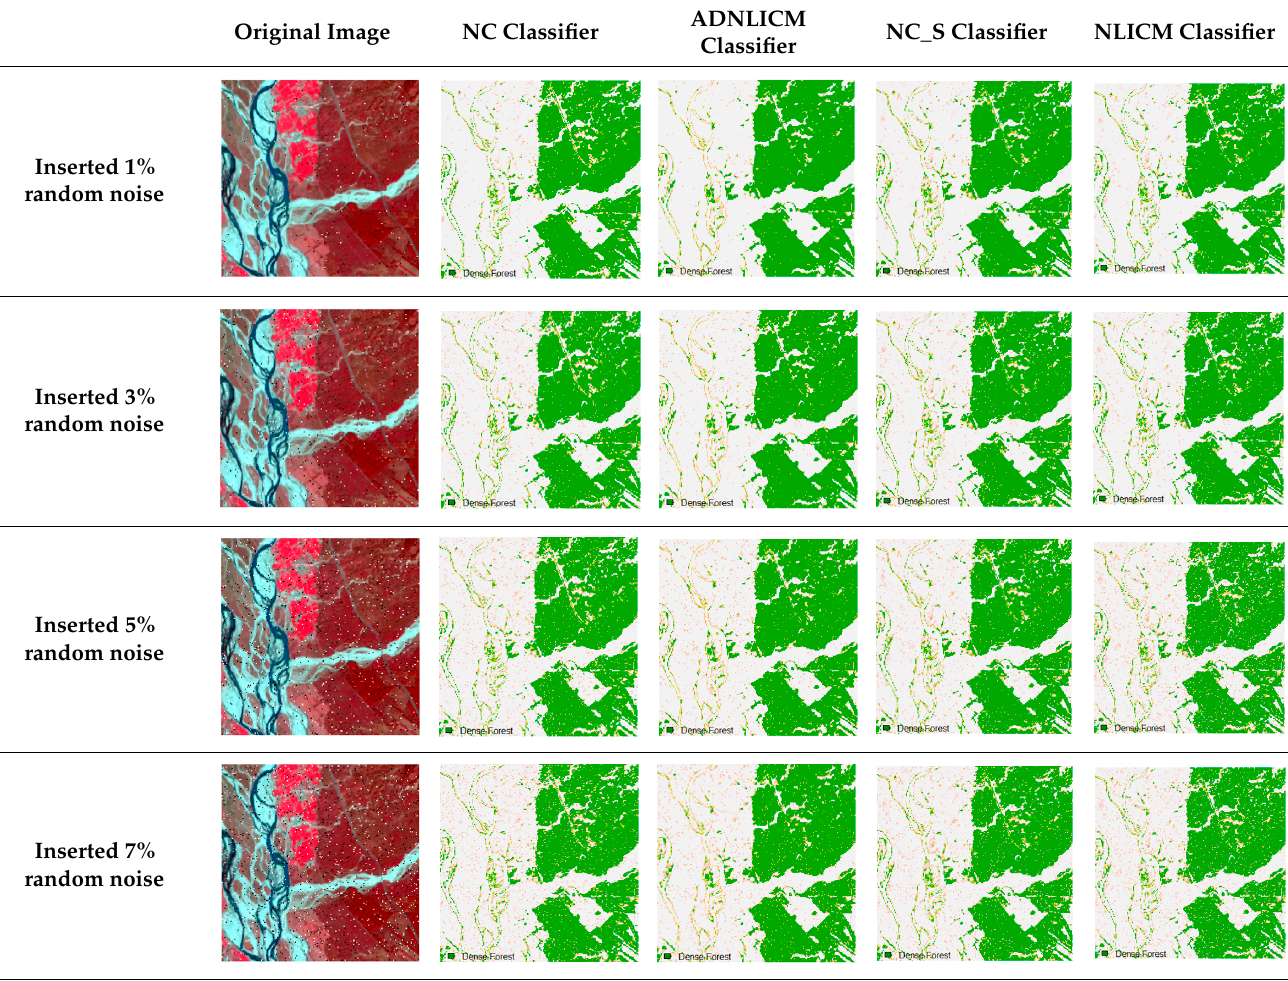
Table 8. RMSE, FERM, and Kappa of the algorithms concerning different random noise (pepper and salt-and-pepper noise) for site 1 (Haridwar). Random Noise